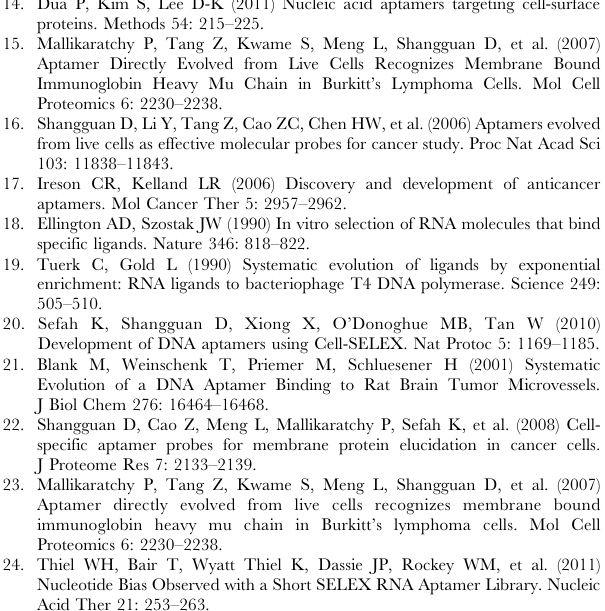
Figure S4 Using aptamer GBM128 to recognize differ- ent FFPE caner tissues. Different FFPE tissue sections were incubated with cy5-labeled aptamer GBM128. A = Brest cancer tissue; B= Renal cell carcinoma tissue; C= Medulloblastoma tissue; D = Hepatocellular carcinoma tissue; E= Small cell lung